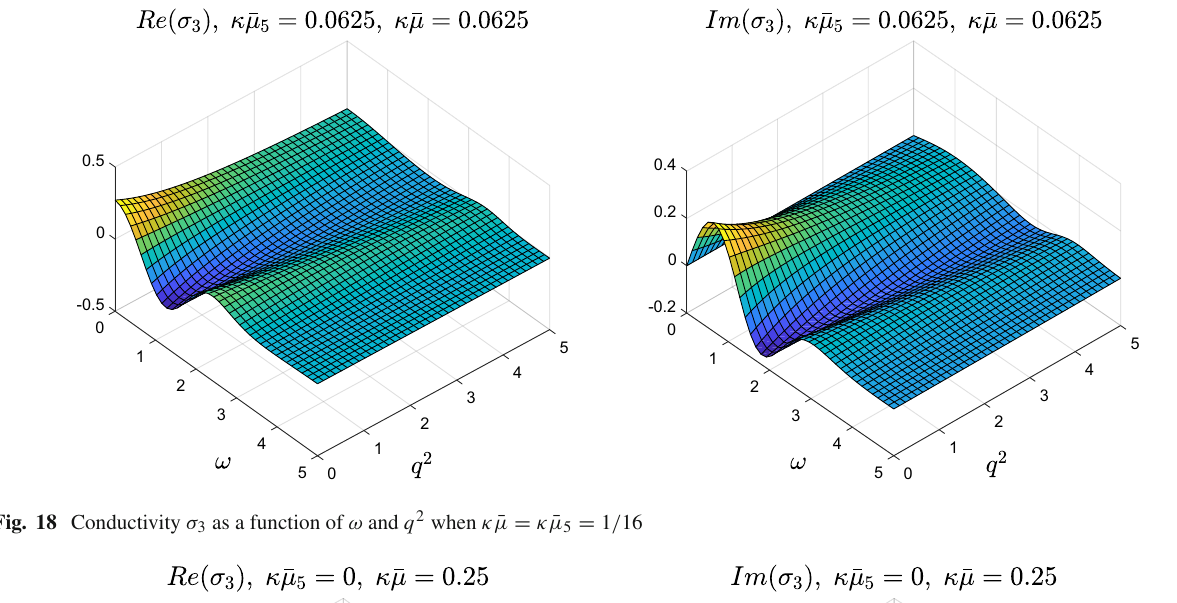
Fig. 18 Conductivity σ 3 as a function of ω and q 2 when κ ¯ μ = κ ¯ μ 5 = 1 / 16